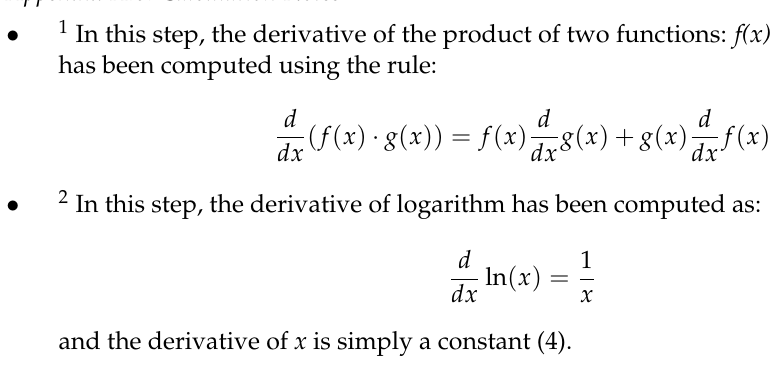
Figure A1. Acceleration ( upper ) and torque ( lower ) using the logarithmic model. MFL = maximum flywheel load. PTL = peak torque load.